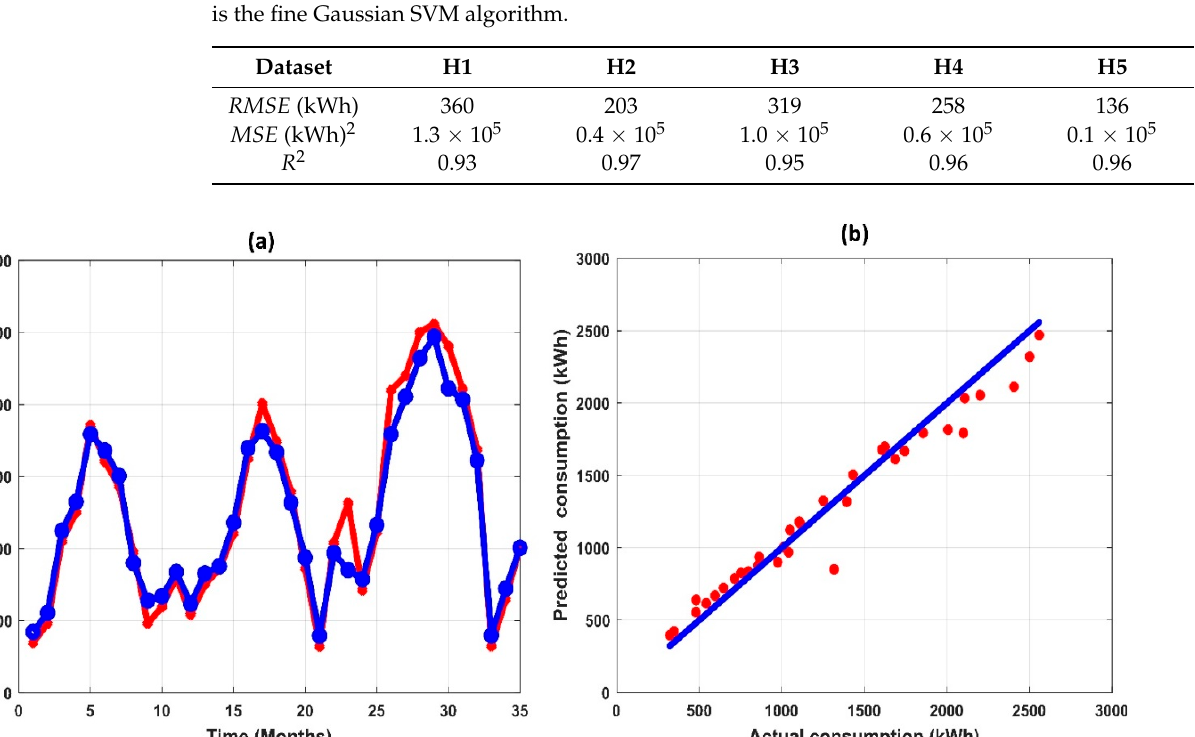
Figure 9. Validation results of the trained model ( a ) predicted (in blue) and actual (in red) response versus time and ( b ) predicted versus actual consumption, blue straight line represents the line of equality .